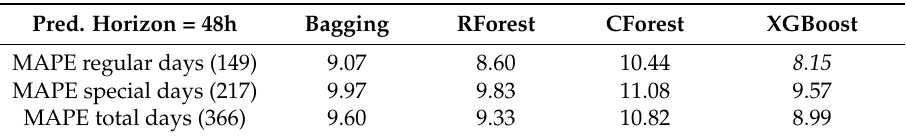
Table 7. MAPE (%) for regular and special days in 2016.